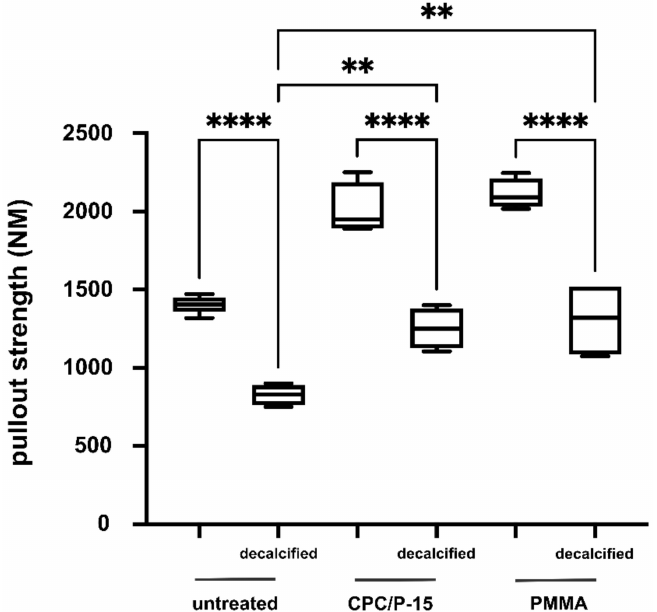
Figure 5. Axial pullout test and BMD in osteoporotic bone. In decalcified vertebrae, F max was significantly lower (1405 ± 55.97 N) compared to not decalcified vertebrae (828 ± 66 N; p < 0.0001). F max was significantly higher in those decalcified vertebrae augmented with CPC/P-15 (1252 ± 131 N; p < 0.0078) and those with PMMA (1308 ± 244 N; p = 0.04). There was no statistically significant difference between PMMA and CPC/P-15 ( p = 0.94). ** p < 0.01, **** p <